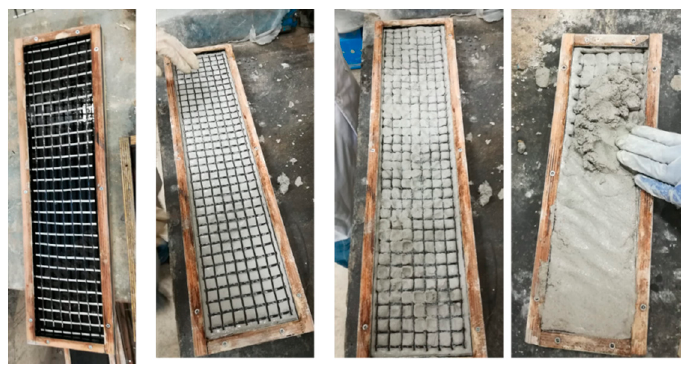
Figure 3. Production stages of composites produced using the M60 matrix.